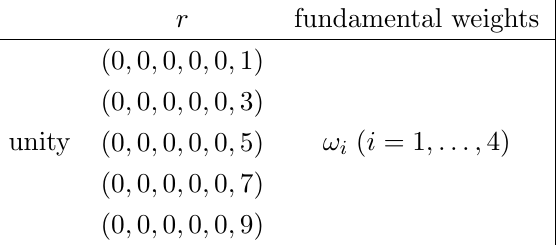
Table 8 . The r -(cid:12)elds of the n = 5 model and the fundamental weights of f 4 which induce the same embedding (cid:30) : Q _ , ! P . All the r -(cid:12)elds and all the fundamental weights induce the same embedding as Q _ = P for f 4